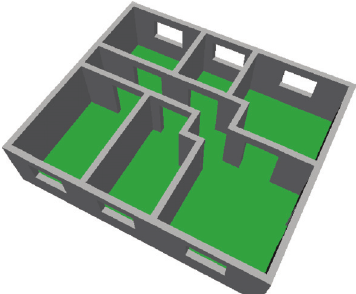
Figure 9: Three-dimensional model of 2D floor plan illustrated in Figure